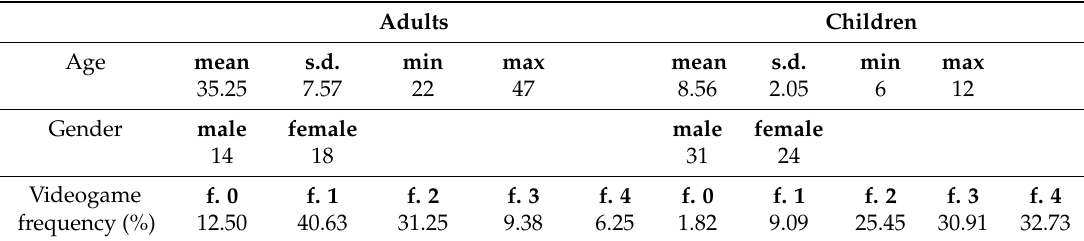
Table 3. Socio-demographic data of the participants.